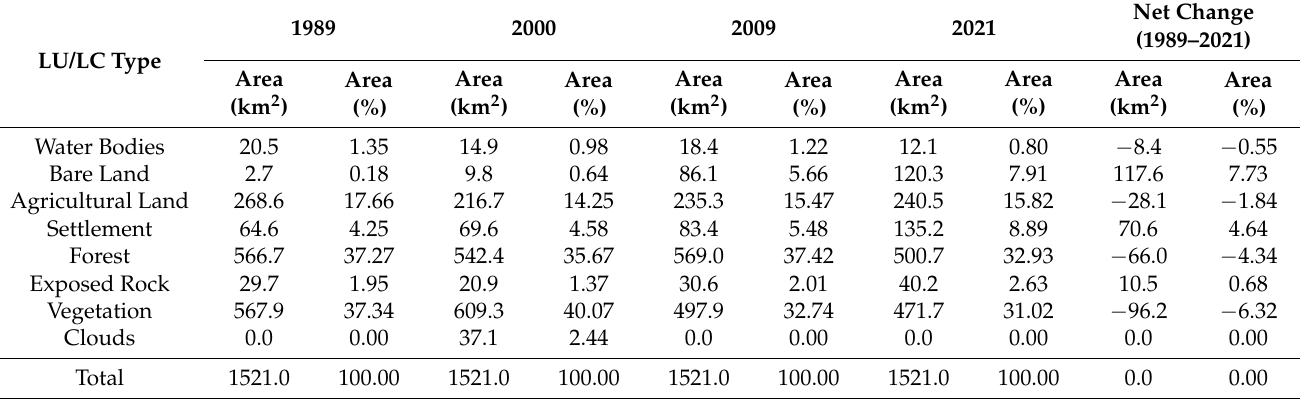
Table 6. LU/LC types of the MORB and corresponding areas in 1989, 2000, 2009, and